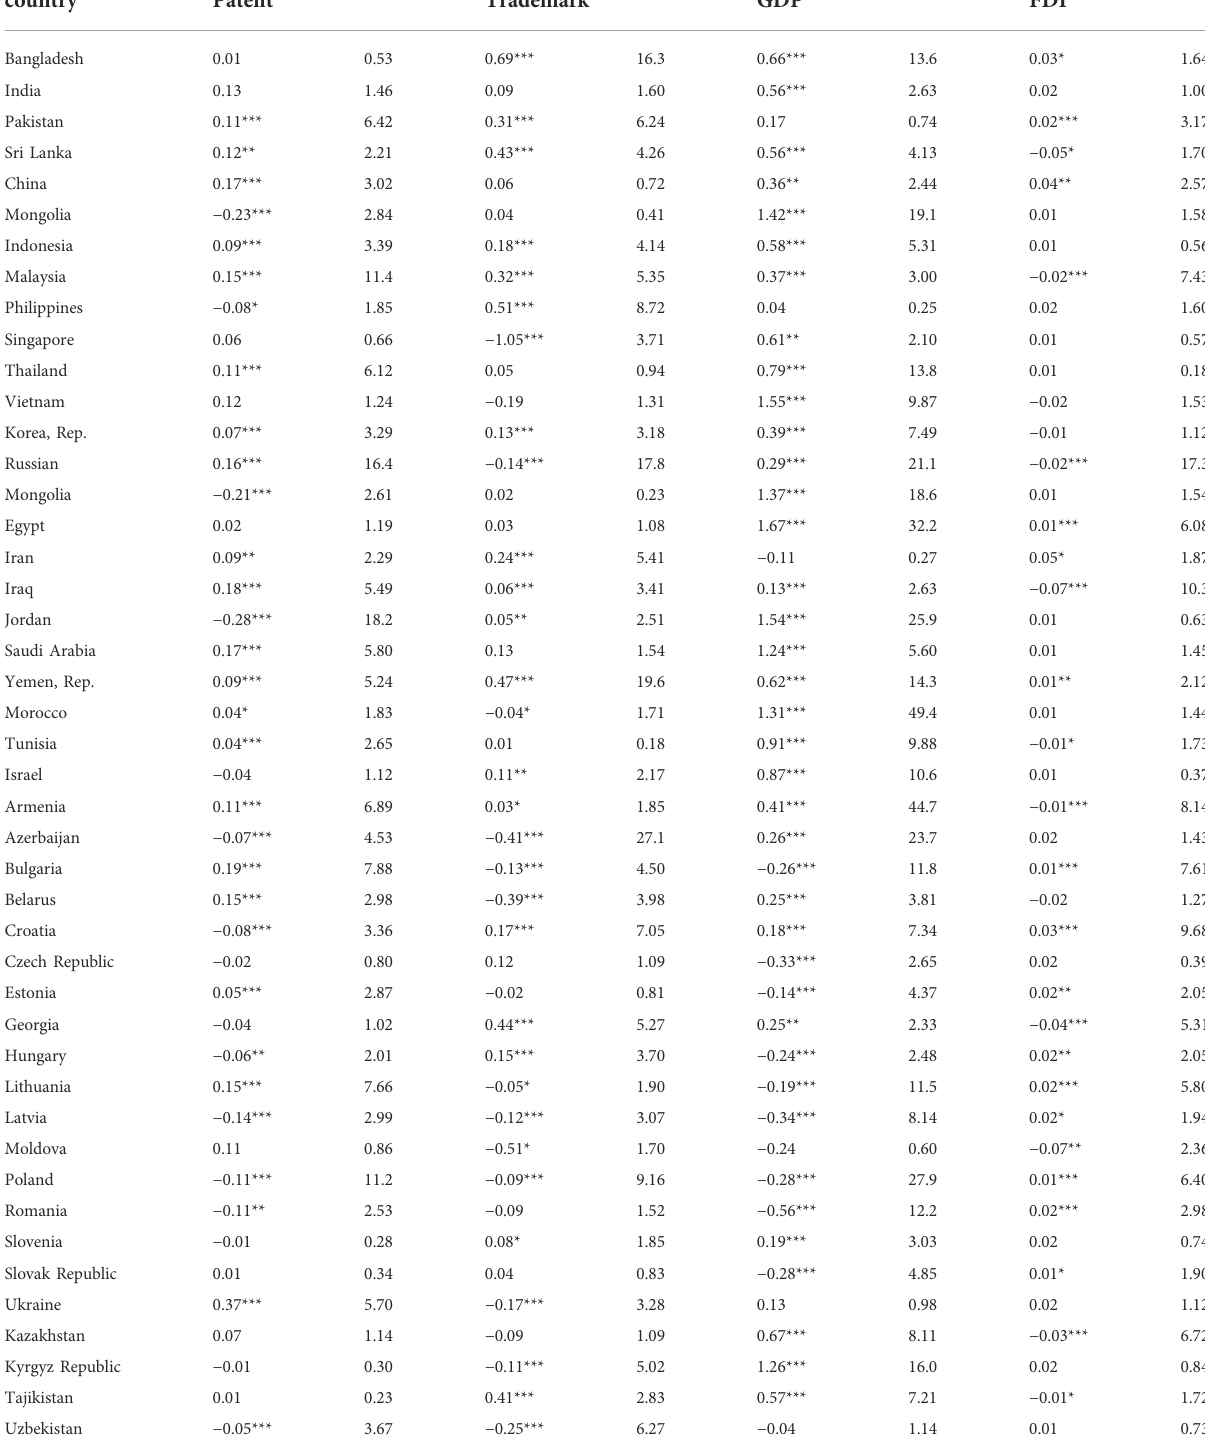
TABLE 9 FMOLS estimates